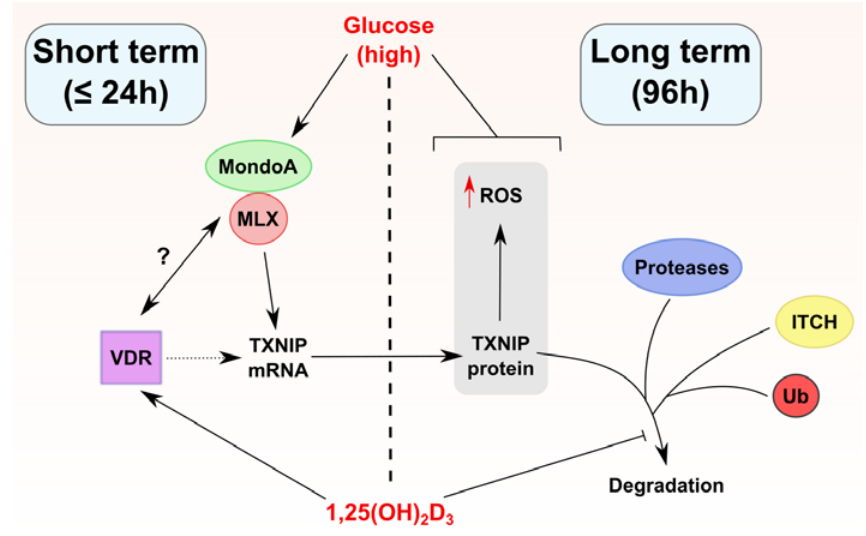
Figure 6. Proposed model of TXNIP regulation by 1,25(OH) 2 D 3 in HL-60 cells. 1,25(OH) 2 D 3 appears to regulate TXNIP expression through multiple mechanisms depending on the duration of treatment (long and short term treatment outcomes are separated in the figure by a dashed line). In short term treatments, 1,25(OH) 2 D 3 induces TXNIP mRNA, but not protein levels, an effect that depends on the availability of glucose. This points toward the possibility that the VDR physically/functionally interacts with the transcriptional heterodimer MondoA/MLX, for example, via enhancing its binding to ChoRE on the TXNIP promoter, or via facilitating its recruitment/nuclear translocation. Such putative interactions are depicted in the figure by a question mark. On the other hand, in long term treatments, 1,25(OH) 2 D 3 induces TXNIP protein expression as well as intracellular ROS levels, effects that are also glucose-dependent. Furthermore, long term treatment with 1,25(OH) 2 D 3 influences TXNIP stability possibly through multi-modal regulation of TXNIP-degrading machinery, for example the E3 ligase ITCH, different proteases, or proteasomal subunits. Whether the TXNIP gene harbors VDRE is unclear, thus the vitamin D receptor (VDR) is linked to TXNIP regulation via a dotted line. A blunted arrow (t-bar) indicates inhibitory activity.